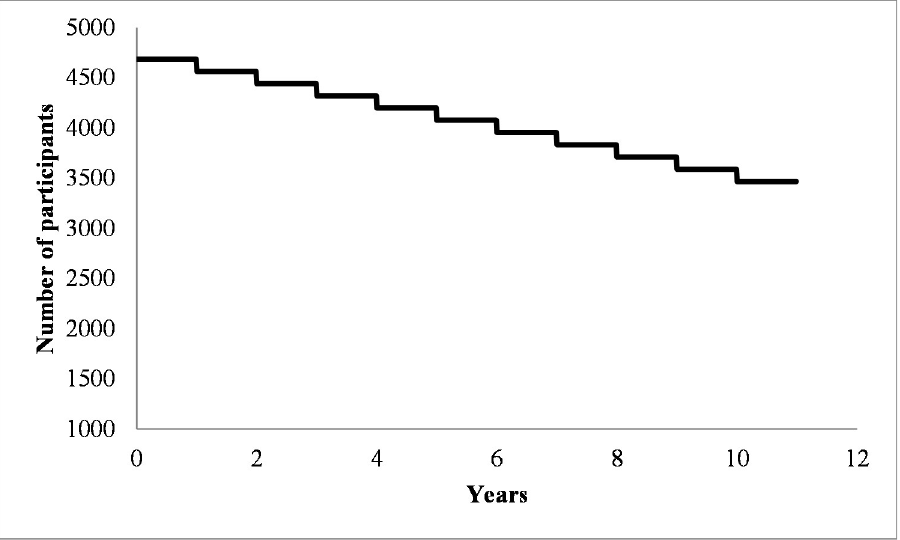
Fig 1. Graphical representation of the expected survival curve of the cohort for neurological and psychiatric diseases, based on epidemiological data